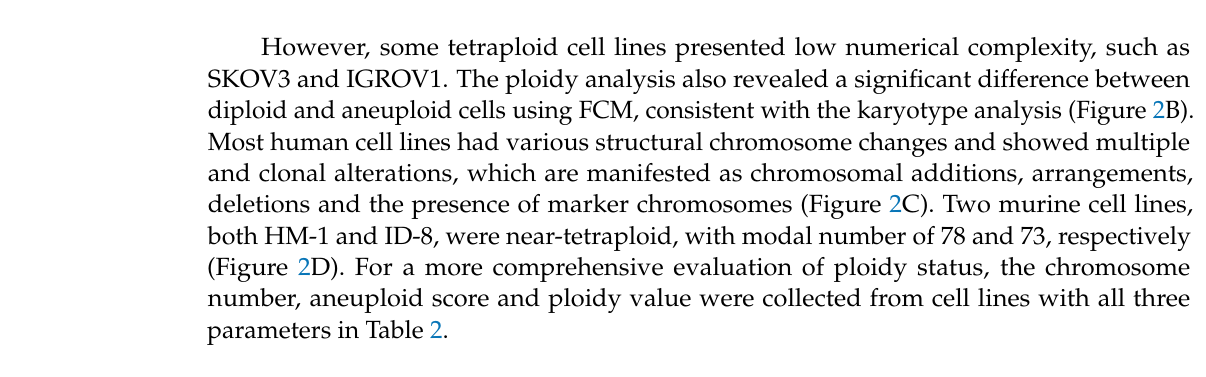
Table 2. Integrated information on the ploidy status of 9 commonly used ovarian cancer cell